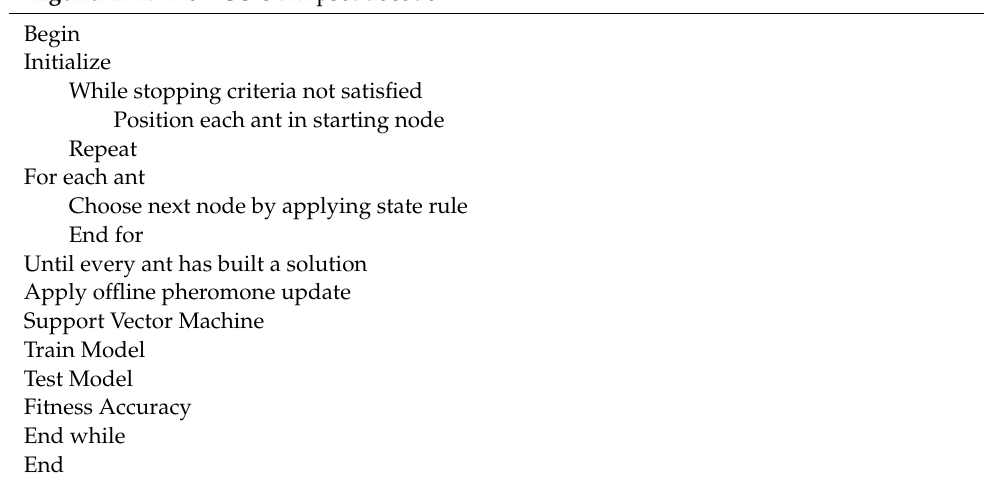
Algorithm 1. The ACO-SVM pseudocode.